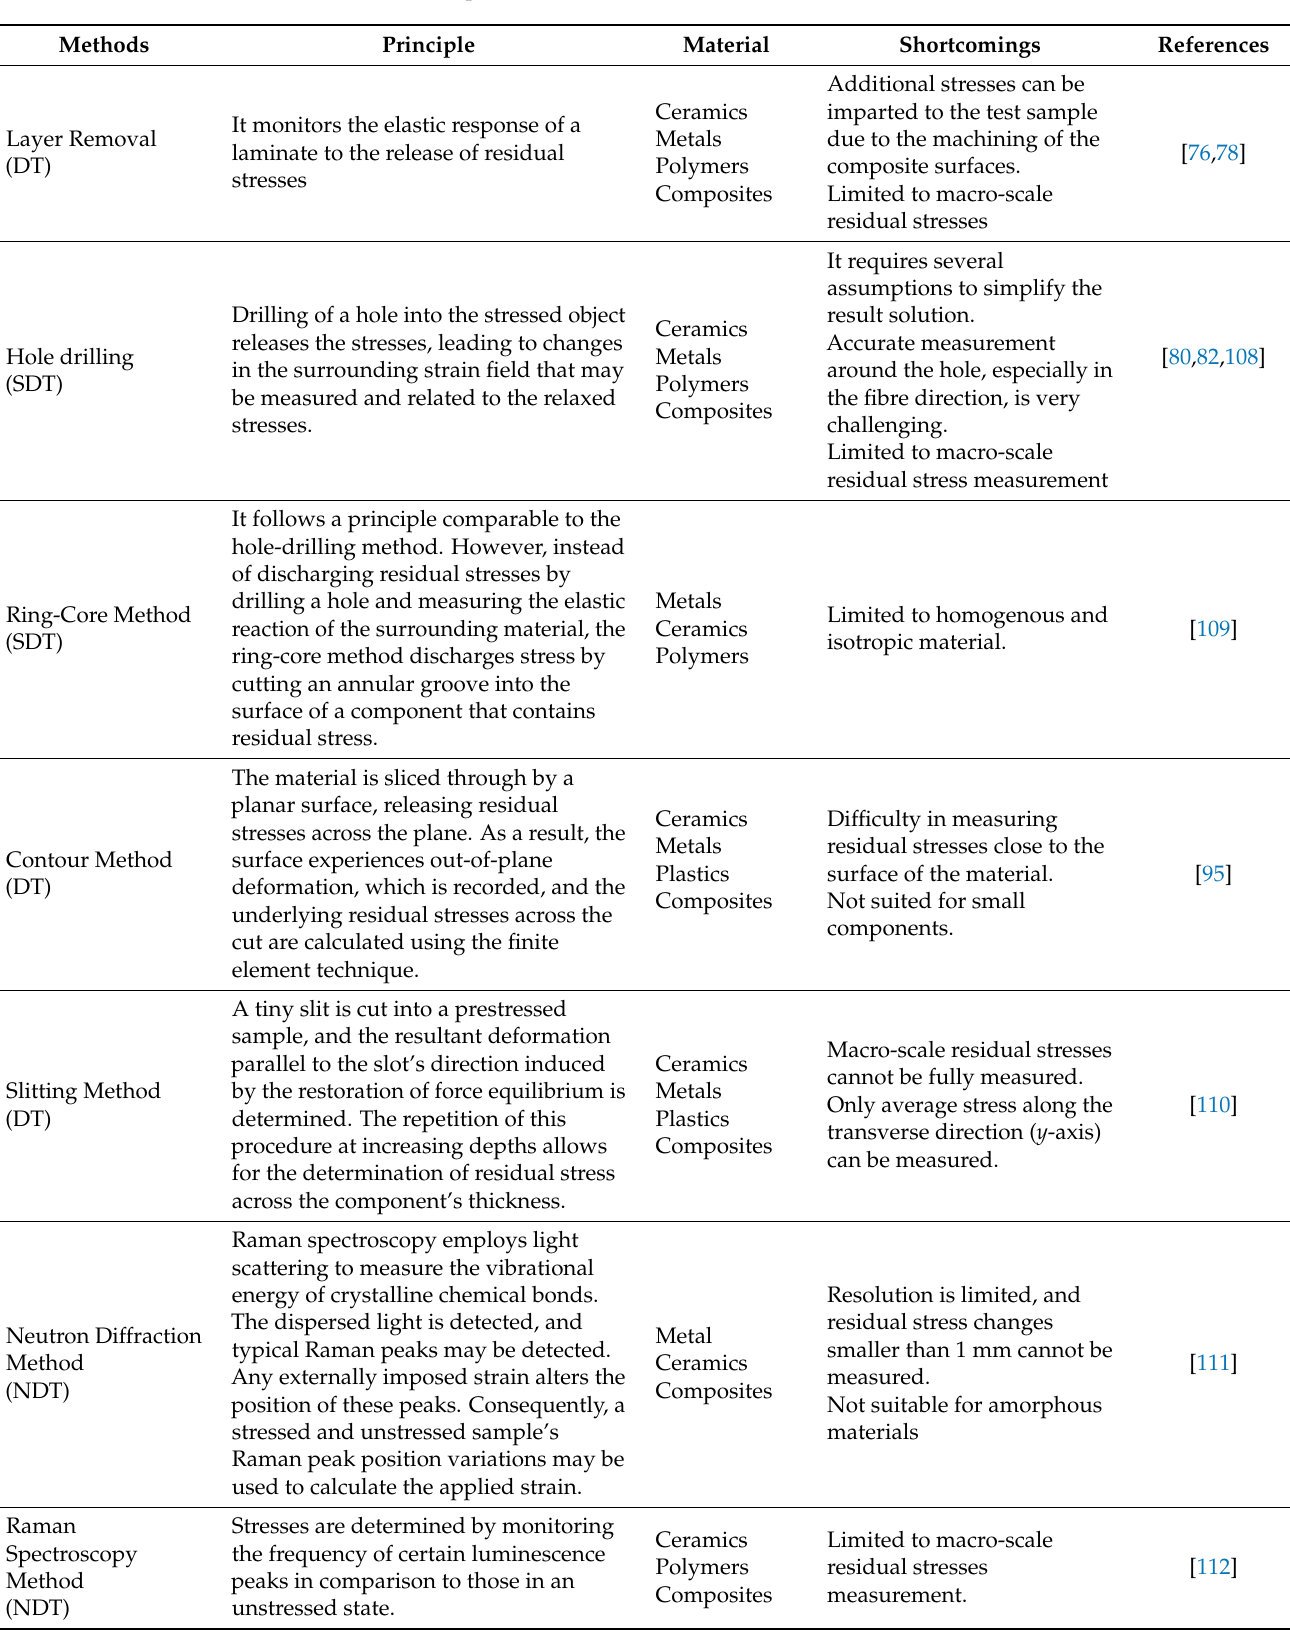
Table 4. Common destructive and non-destructive test methods used in the calculation of residual stresses in